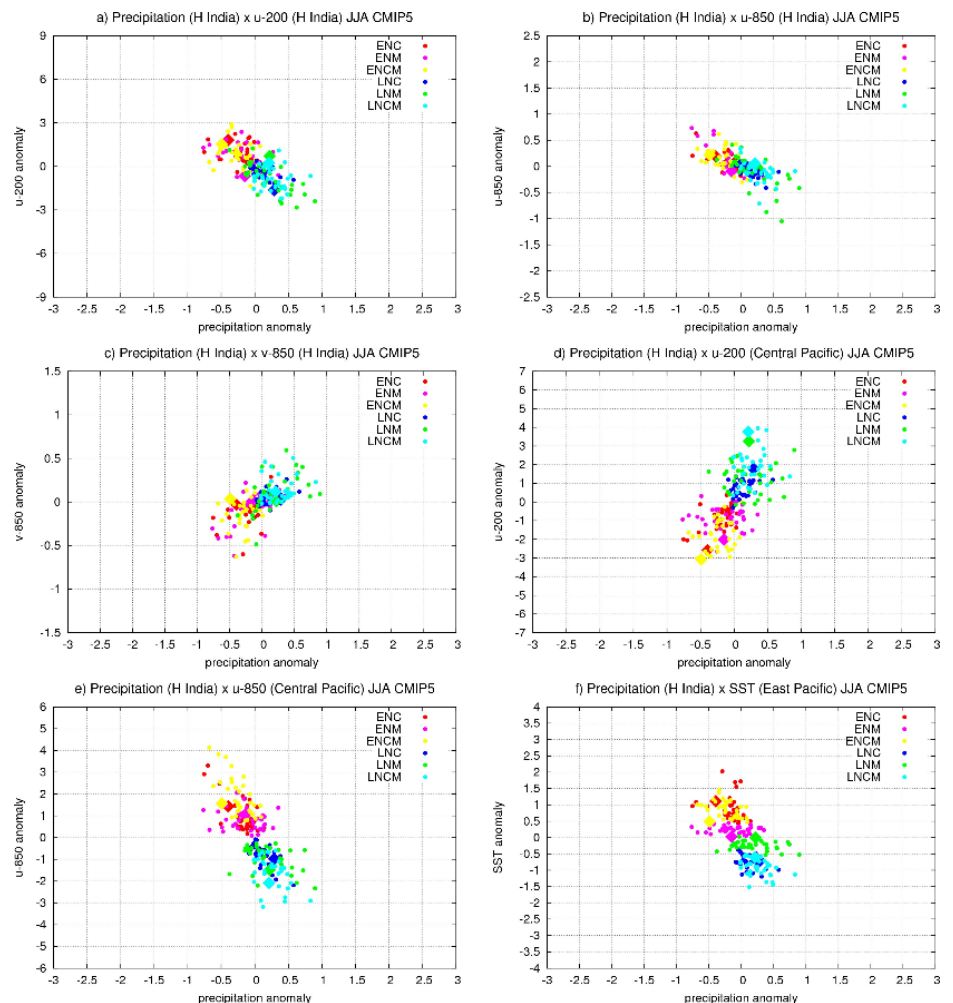
Figure 4. H Region: ISM precipitation (mm/day) vs. various fields. Precipitation vs. local atmospheric influence of wind (m/s) is shown for U200 ( a ), U850 ( b ) and V850 ( c ). Precipitation vs. remote influence from Central Pacific (U200 ( d ), U850 ( e )), and East Tropical Pacific SST (°C) are also shown ( f ).